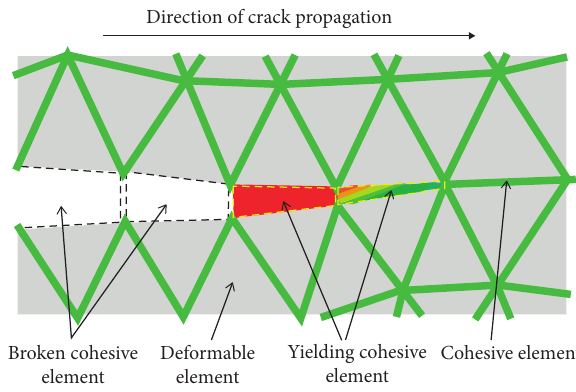
Figure 15: The simulated crack propagation process with